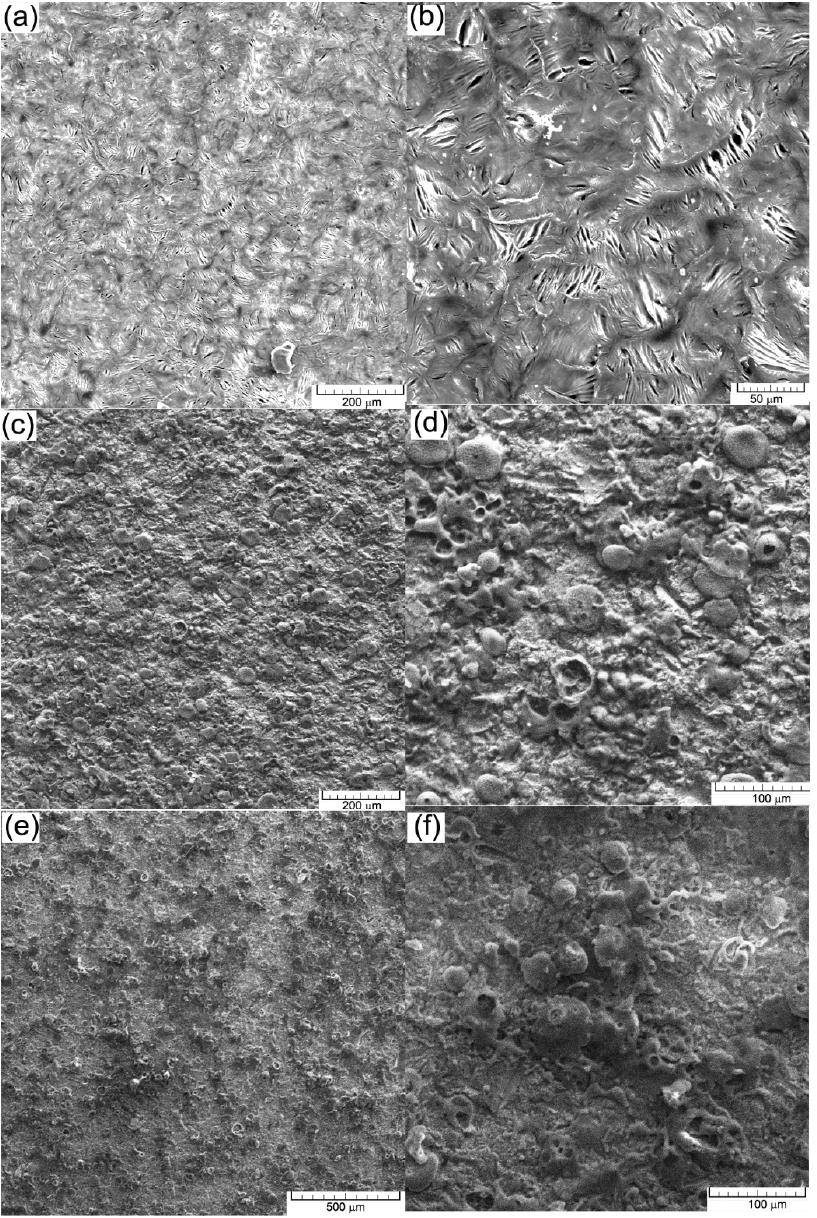
Figure 12. SEM images on the surface after the electrochemical test: ( a , b ) cast iron EN-GJL-250; ( c ) and ( d ) EN-GJL-250 + 2 ceramic layers; ( e , f ) EN-GJL-250 + 4 ceramic layers.